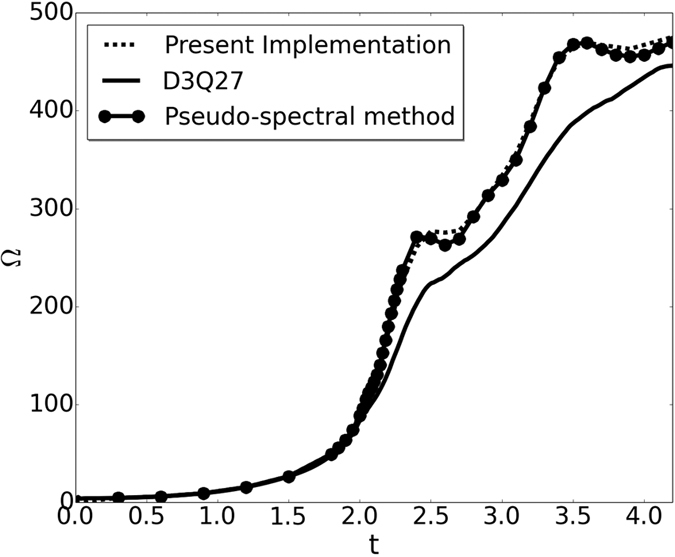
Variation of Enstrophy (Ω) with time (t) for Kida-Pelz flow at Re = 10,000 on 12003 grid.